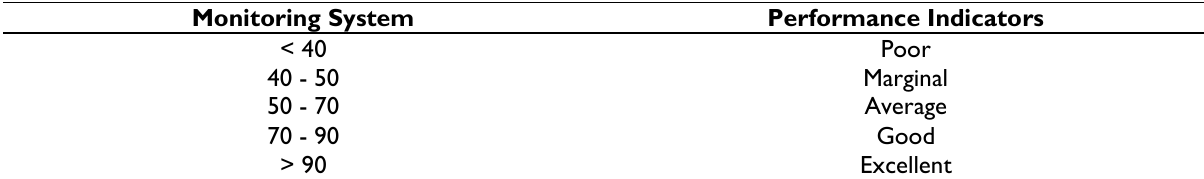
Table 3. Performance Indicator Monitoring